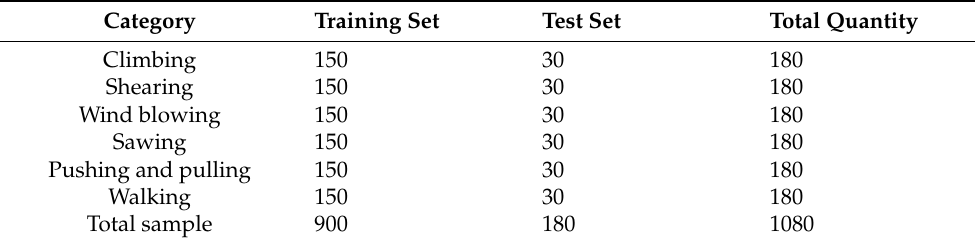
Table 1. Data set